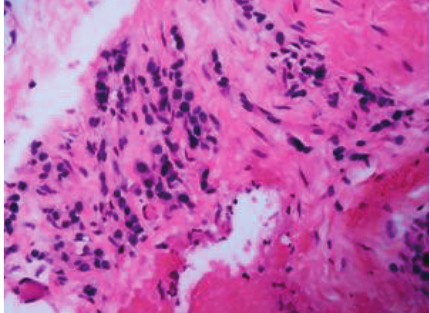
Figure 3: (H&E, 20x) CT-guided psoas muscle biopsy showing tumor cells in the dense fibroconnective tissue with background lymphocytes. The individual tumor cells are atypical, pleomorphic, and hyperchromatic in an infiltrative pattern and were cytokeratin positive,confirmingthediagnosisofmetastaticpoorlydifferentiated carcinoma.